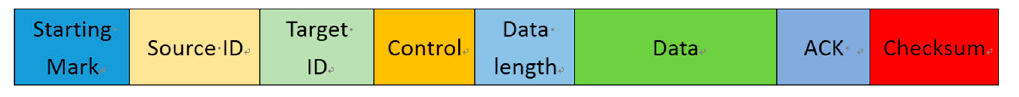
Figure 6. Format of frame.